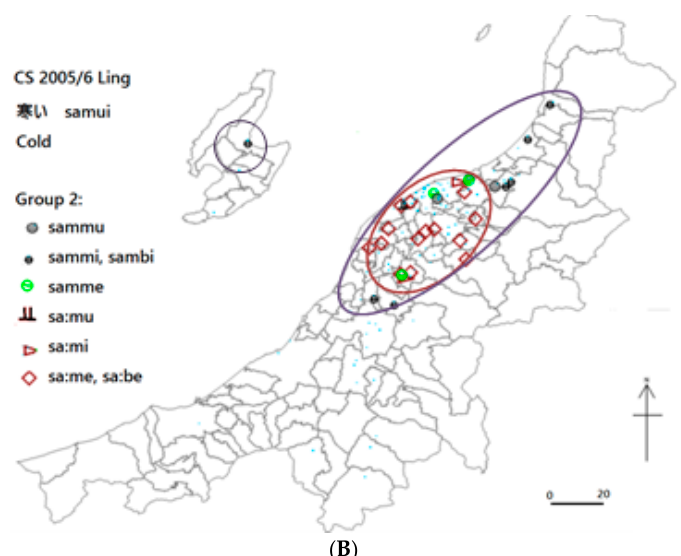
Figure 4. ( A ) Map (Group 1) of samui “cold” in Niigata: 2005/6 CS Survey. ( B ) Map (Group 2) of samui “cold” in Niigata: 2005/6 CS Survey.